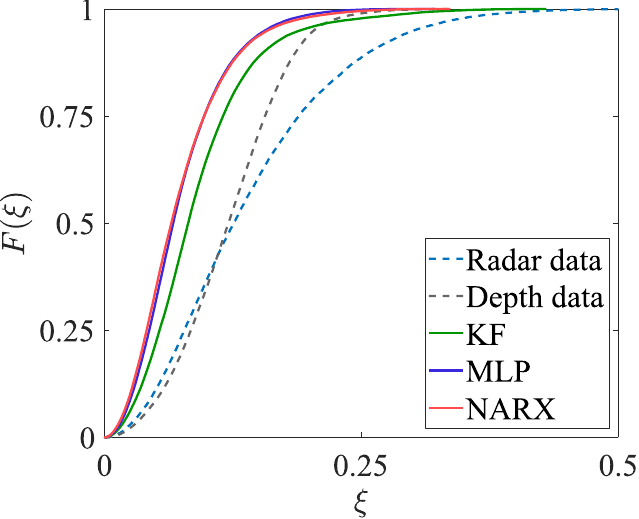
Figure 7. Estimates of the trajectories obtained in experiment EXP#2, on the basis of the radar data ( a ), the depth data ( b ), and the fused data ( c – e ); the black dashed lines denote the reference trajectories.